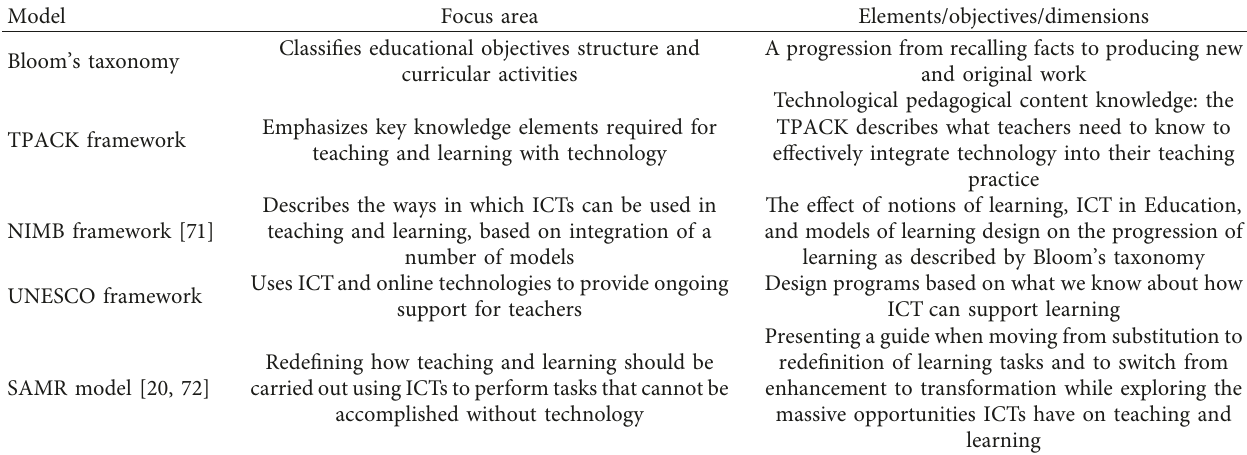
Table 3: Models for integrating ICTs for teaching and learning in education